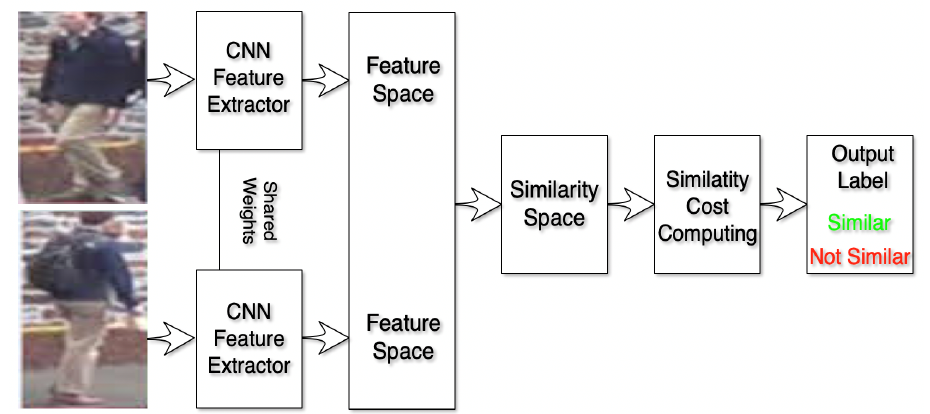
Figure 2. Common base architecture for person